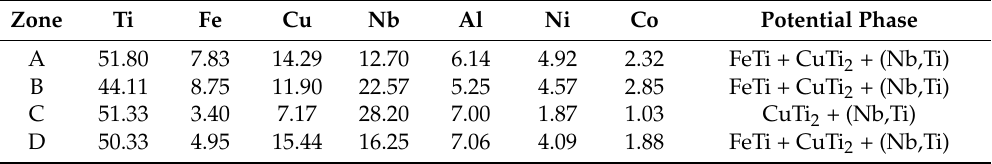
Table 4. The main chemical compositions of different zones (at %) at titanium alloy